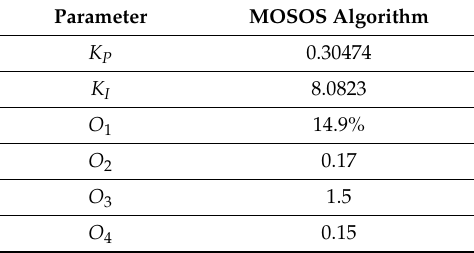
Table 2. Optimal PI values.